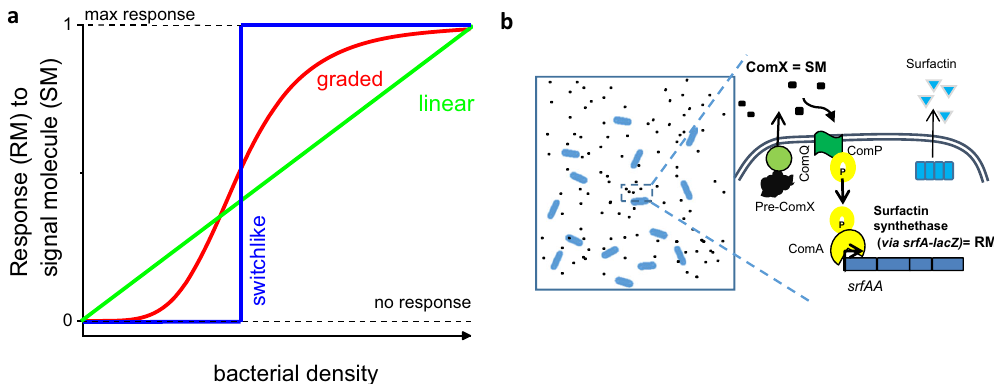
Fig. 1 The modes of the signal molecule concentration-dependent response as a function of bacterial density. a A communication system, where the response is linearly dependent on bacterial density tracks the bacterial density, however, there is no threshold density at which one could de fi ne the quorum. The switchlike transition from no response to max response describes an ideal quorum sensing system where upon reaching a critical concentration the QS response is attained. The less ideal, but anyway non-linearly controlled by the bacterial density, is the graded QS response. b The type of response mode in B. subtilis ComQXPA communication system where the peptide ComX activates the response, which is the transcription of genes encoding the response molecule (RM) surfactin synthethase, is